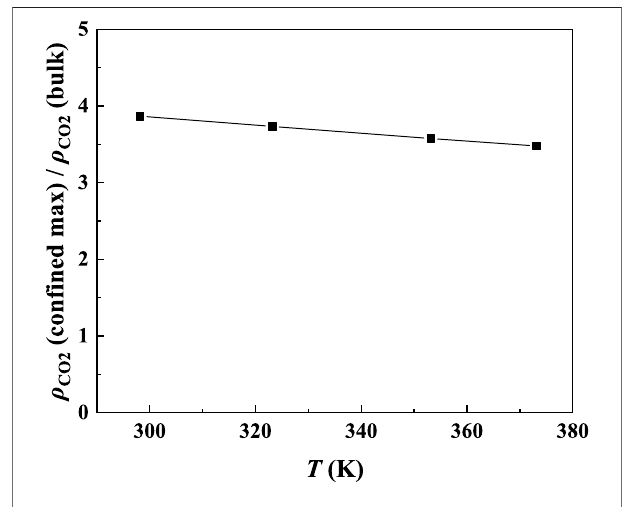
FIGURE 7 | Ratios of the maximum density of CO 2 in the con fi ned [C